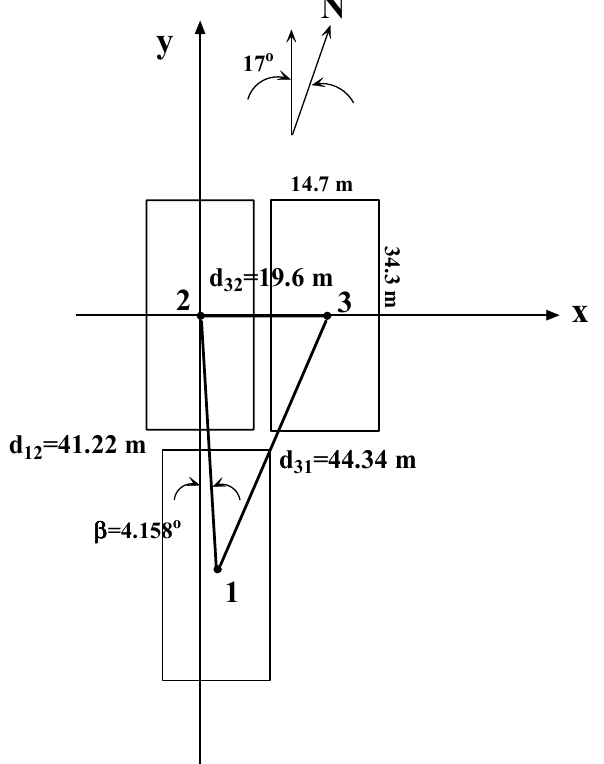
Fig. 1 Fig. 1. Geometry of Chung-Li VHF radar antenna array used for interferometer observation. The origin is at the phase center of antenna array 2. The y-axis points toward 17 ◦ west of geocentric north. The phase center of antennas 2 and 3 determine the x-axis, and the z-axis points into the zenith